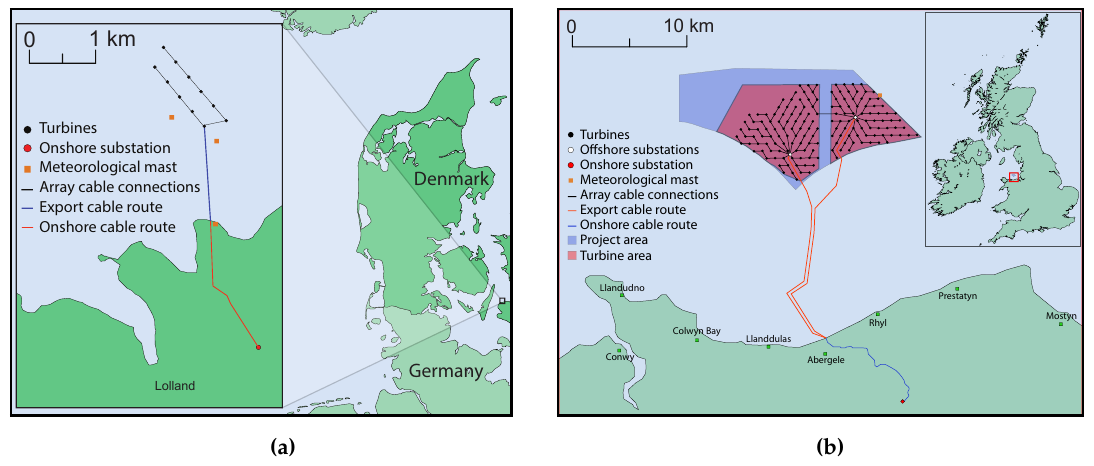
Figure 3. Differences in topology and design complexity between two OWFs. ( a ) Vindeby wind farm [10]; ( b ) Gwynt y Môr wind farm